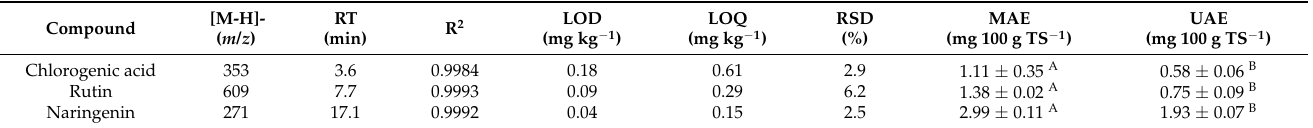
Table 6. Main polyphenols quantified in TSE under optimum MAE and UAE conditions ( n = 3; mean ± SD). Different superscripts within the same row indicate significant differences between extracts ( p < 0.05).